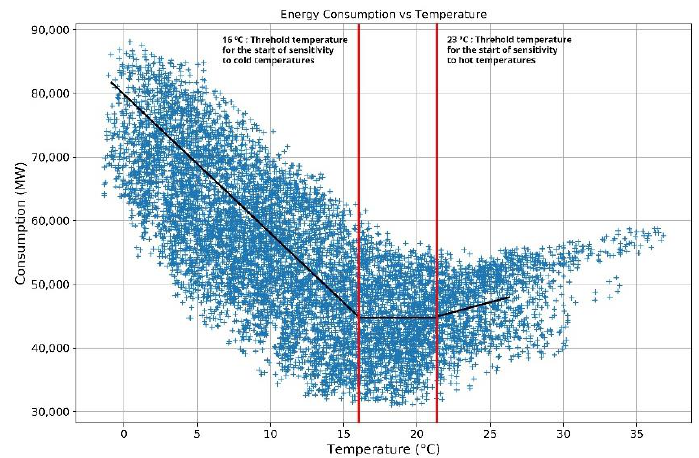
Figure 3. Correlation between energy consumption and temperature as provided by the R é seau de Transport d’Electricit é (RTE).